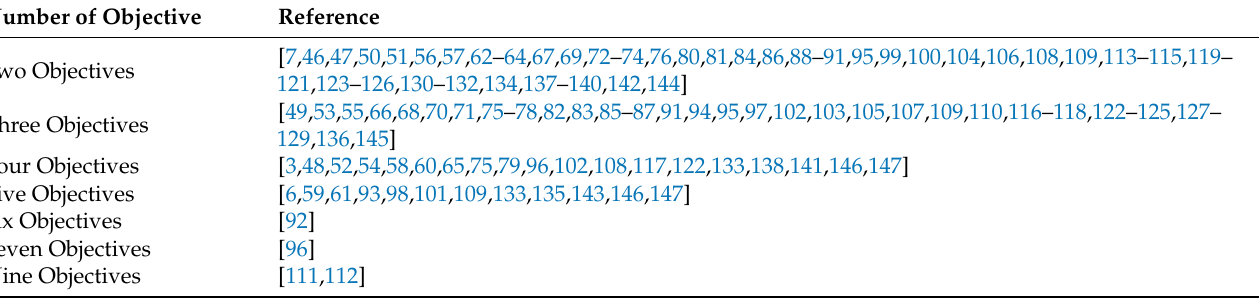
Figure 12. Studies using number of objectives. Table 5. Number of objectives used in the studies and their references